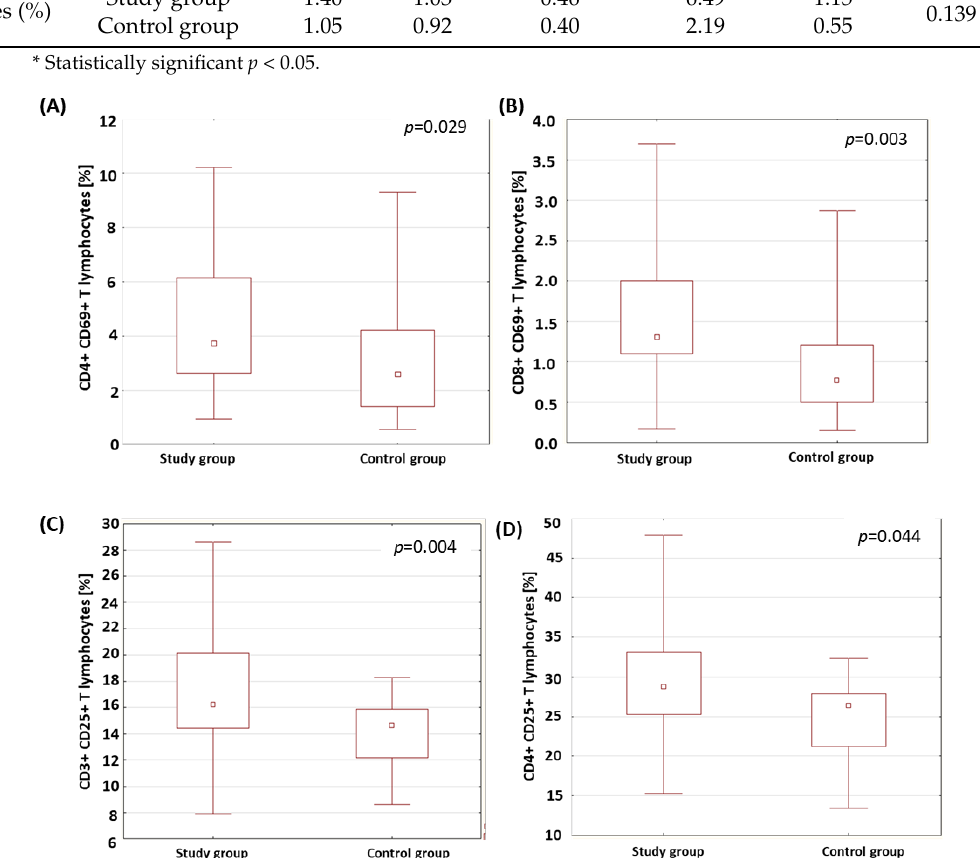
Figure 1. Comparison of the percentage of selected subpopulations of lymphocytes with CD69- and CD25-antigen expression in the study group and the control group. ( A ) Comparison of the percentage of CD4+ T lymphocytes with CD69-antigen expression in both analyzed groups; ( B ) comparison of the percentage of CD8+ T cells with CD69-antigen expression in both analyzed groups; ( C ) comparison of the percentage of CD3+ T cells with CD25-antigen expression in both analyzed groups; ( D ) comparison of the percentage of CD4+ T cells with CD25-antigen expression in both analyzed groups.